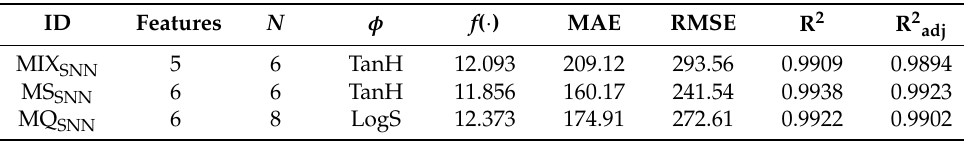
Table 2. Comparison between SNN models.